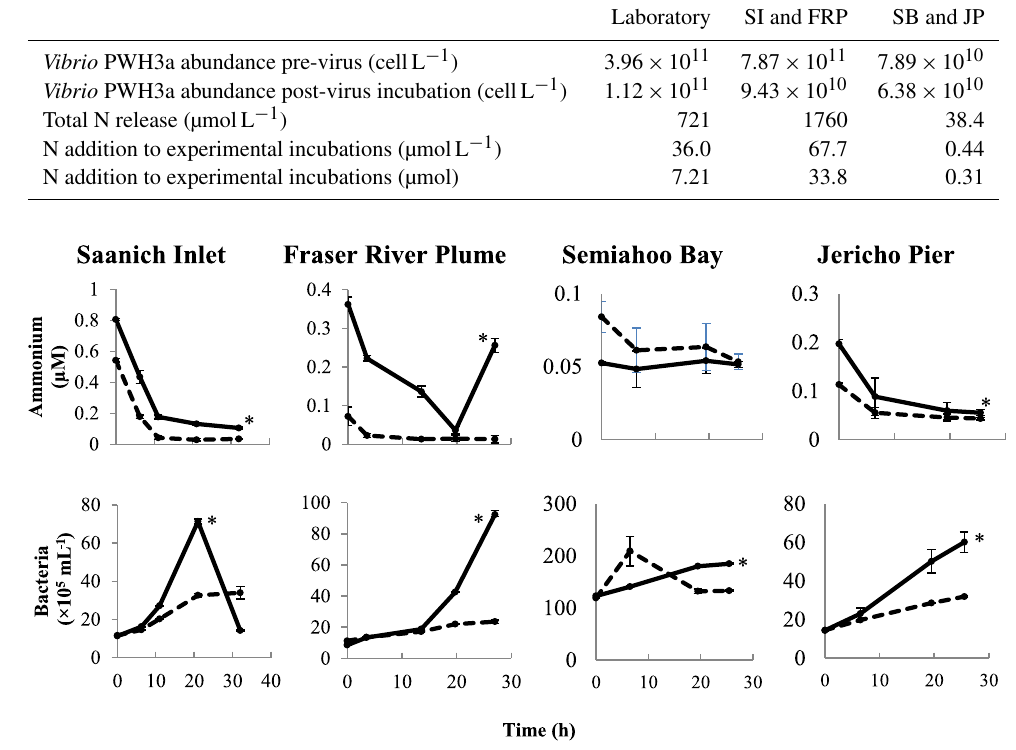
Figure 2. Time course of ammonium concentrations and bacterial abundances in the field experiments. Solid and dashed lines indicate treatments with lysate addition (SW + lysate) or without (SW), respectively. Error bars are standard errors of triplicate incubations. Asterisks indicate significant differences between treatments. Note that the scales are different among